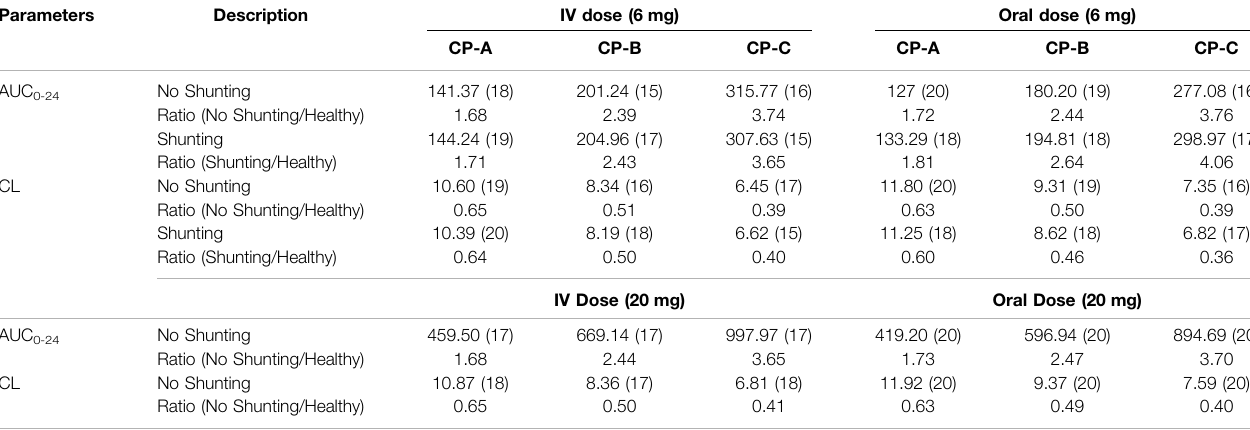
TABLE 4 | Predictions of dexamethasone pharmacokinetics in virtual populations with varying degrees of liver disease. Parameters